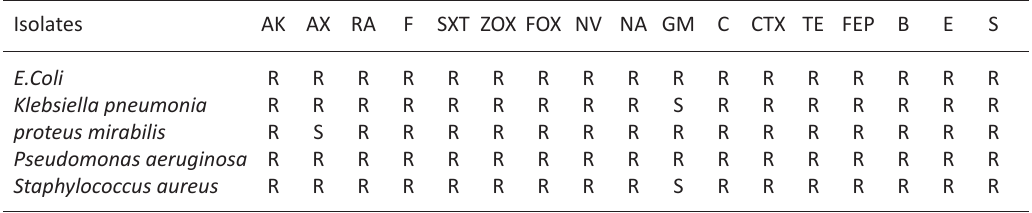
Table 3. Antimicrobial sensitivity manner for pathogens producing urinary tract infections (UTIs) in Basra, south Iraq Isolates